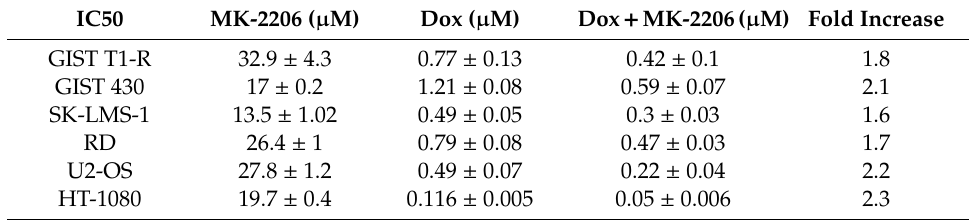
Figure 1. An impact of AKT inhibition on cytotoxic activity of doxorubicin (Dox) in soft tissue sarcomas (STS) and gastrointestinal stromal tumors (GIST). ( A ) MTS-based viability assay in RD rhabdomyosarcoma, U2-OS osteosarcoma, HT-1080 fibrosarcoma, GIST T-1R, GIST 430 and SK-LMS-1 leiomyosarcoma cells treated with Dox alone (solid lines) or in combination of MK-2206 (dashed lines) for 72 h. The data was normalized to DMSO-treated controls. Values are the means ± standard deviation ( n = 3). ( B ) the heat-map illustrating the combination index (CI) values for Dox and MK2206 combinations at various molar ratios for cancer cell lines indicated above. CI values were calculated with CompuSyn Software (Version 1.0), based on the Chou–Talalay algorithm. CI values < 1 indicate the synergy between Dox and MK-2206. Table1. IC50valuesforDoxinSTSandGISTtreatedinabsenceorpresenceofMK-2206,